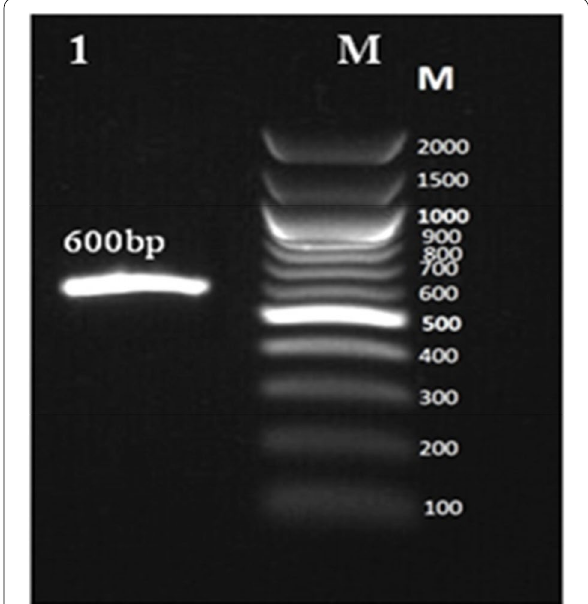
Fig. 1 Agarose gel electrophoresis for PCR product (600 bp) of ITS region from A. terreus strain RGS. Eg‑NRC; M, 100 bp DNA ladder (Invitrogen, California,